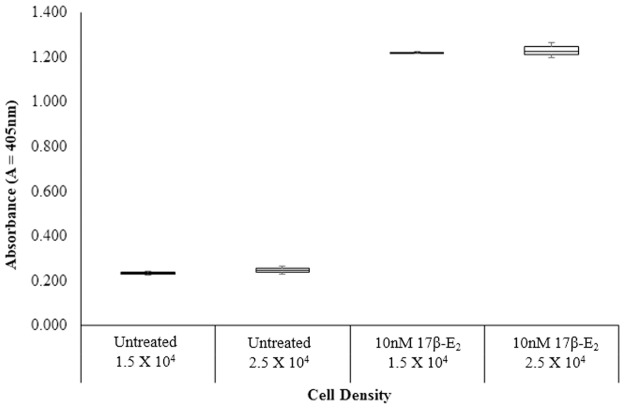
Effect of varying seeding density on the effect of 17β-E2 on the induction of cell proliferation in Ishikawa cells in comparison to the untreated control.The values represent the mean activity of three treatment group.